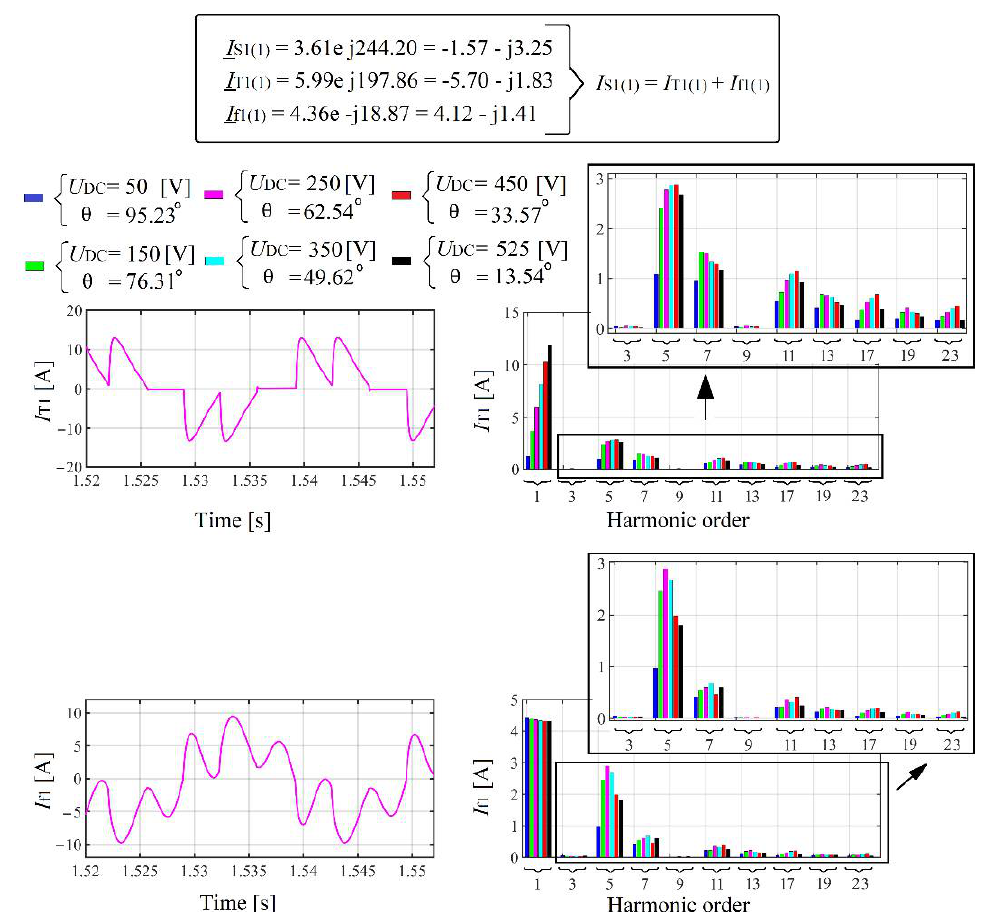
Figure 47. Waveforms and spectrums of input rectifier current ( I T1 ) and filter current ( I f1 ).